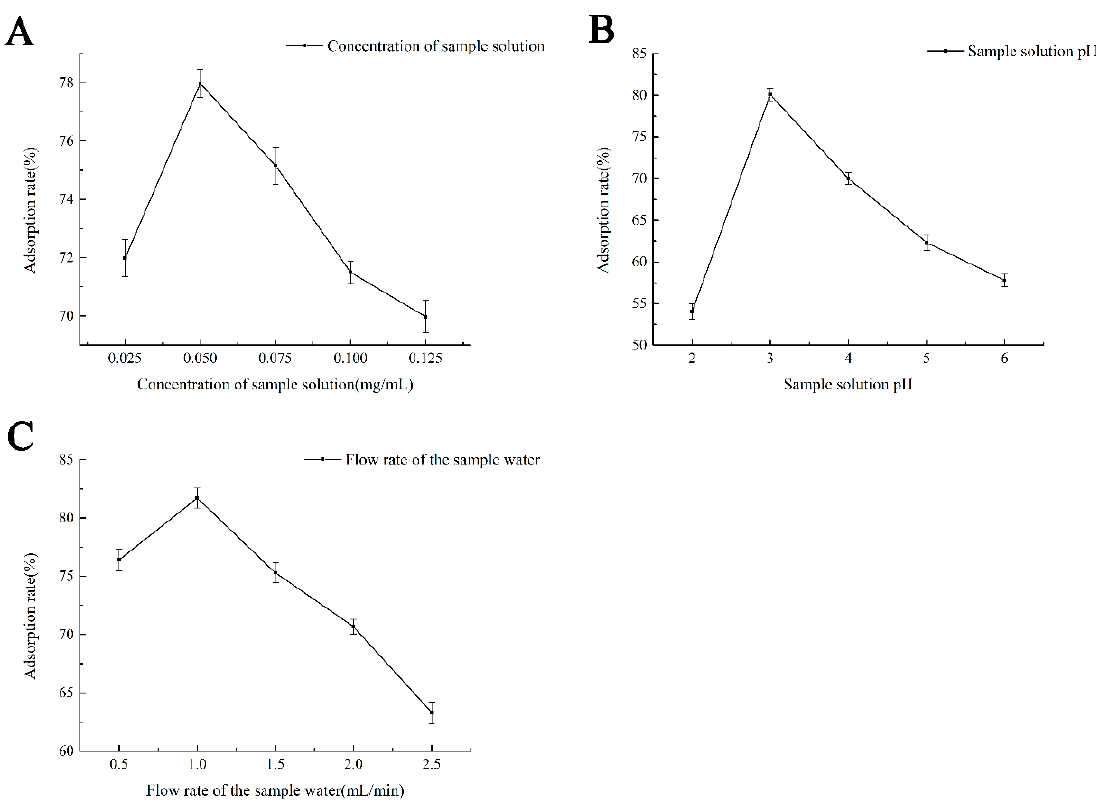
Figure 4. Effects of different purification parameters on naringin extraction rate. ( A ) The effect of Figure 4. E ff ects of di ff erent puri fi cation parameters on naringin extraction rate. ( A ) The e ff ect of loading concentration on the adsorption rate of naringin; ( B ) The effect of pH of sample solution on loading concentration on the adsorption rate of naringin; ( B ) The e ff ect of pH of sample solution on the adsorption rate of naringin; ( C ) The effect of sample loading velocity on adsorption rate. the adsorption rate of naringin; ( C ) The e ff ect of sample loading velocity on adsorption rate.